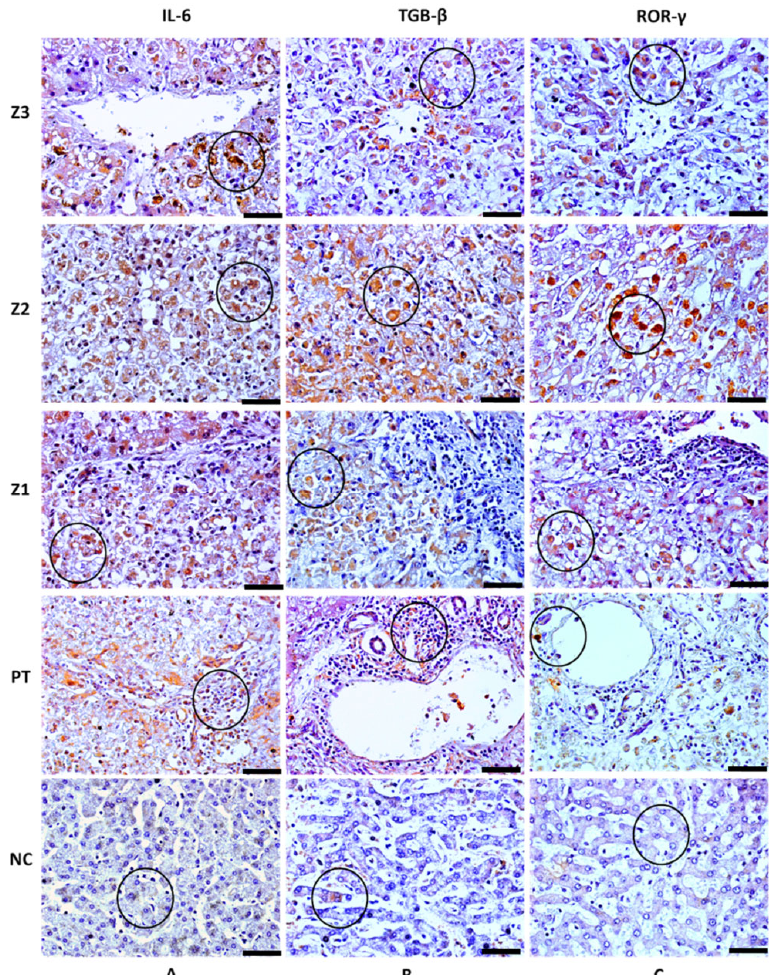
Figure 2. Positive immunohistochemistry staining for IL ‐ 6, TGF ‐β , and ROR ‐γ in the zones Z3, Z2, and Z1 and PT in the liver parenchyma of patients with fatal YF and normal controls. ( A ) Immunolabeling for IL ‐ 6 (circle) in Kupffer cells ( A ‐ Z3 ), hepatocytes ( A ‐ Z2 , A ‐ Z1 ), and the inflammatory infiltrate ( A ‐ PT ). ( B ) Immunolabeling for TGF ‐β (circle) in hepatocytes ( B ‐ Z3 , B ‐ Z2 , B ‐ Z1 ) and in the inflammatory infiltrate ( B ‐ PT ). ( C ) Immunolabeling for ROR ‐γ (circle) in hepatocytes ( C ‐ Z3 , C ‐ Z2 , C ‐ Z1 ) and T cells ( C ‐ PT ). Ab ‐ sence of labelling for IL ‐ 6 and preservation of the liver parenchyma ( A ‐ NC ), slight labelling for TGF ‐β and ROR ‐γ in Z2, and preservation of the liver parenchyma ( B ‐ NC , C ‐ NC ). Magnification: 400× (scale bar, 20 μ m). Z3: Pericentral zone; Z2: Midzonal zone; Z1: Periportal zone; PT: Portal tract. (Patient